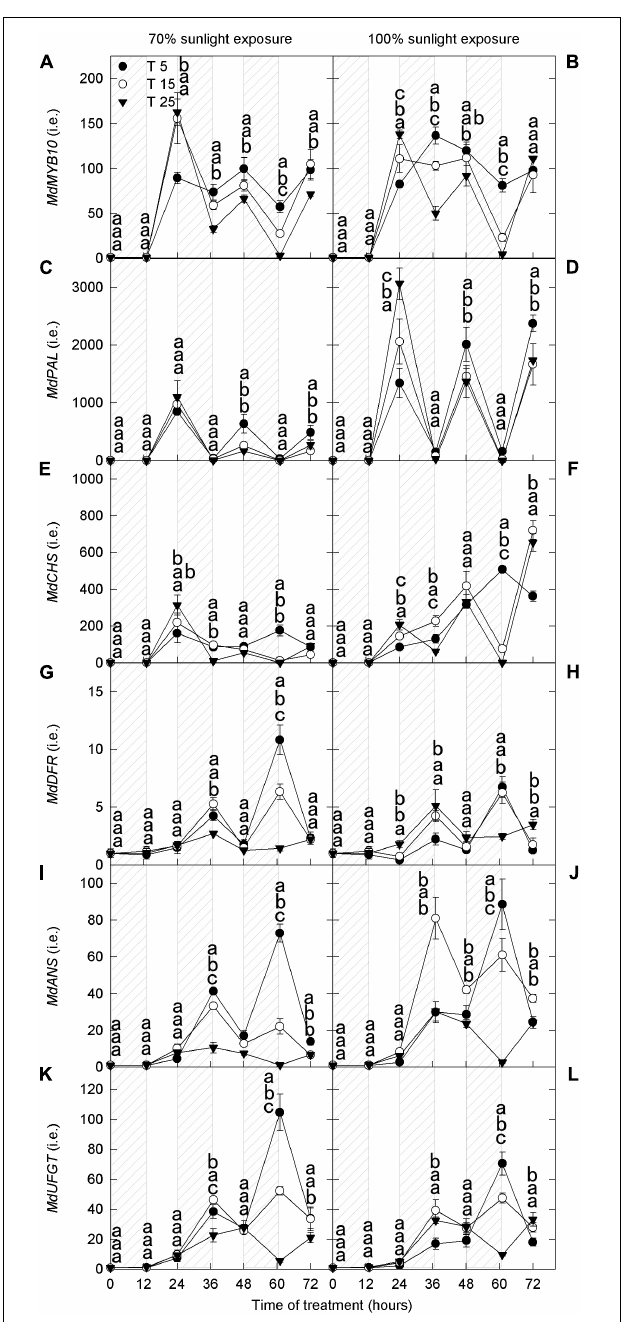
FIGURE 2 | Transcript levels of genes related to anthocyanin synthesis in the peel of “Fuji” apple exposed to different nighttime temperatures and sunlight intensities. The relative transcript level of MdMYB10 (A) , MdPAL (C) , MdCHS (E) , MdDFR (G) , MdANS (I) , and MdUFGT (K) in the peel of “Fuji” apples exposed to nighttime temperatures of 5, 15, 25 ◦ C and 70% sunlight intensity. The relative transcript level of MdMYB10 (B) , MdPAL (D) , MdCHS (F) , MdDFR (H) , MdANS (J) , and MdUFGT (L) in the peel of “Fuji” apples exposed to nighttime temperatures of 5, 15, and 25 ◦ C and 100% sunlight intensity. PAL, phenylalanine ammonia-lyase ; CHS, chalcone synthase ; DFR, dihydroflavonol reductase ; ANS, anthocyanidin synthase ; UFGT, UDP galactose: flavonoid 3-O-glycosyltransferase . Different lowercase letters indicate significant difference among treatments at P <